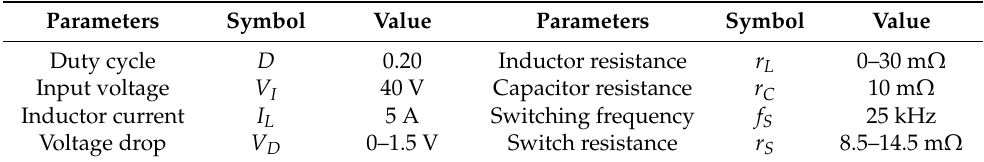
Table 2. Non-ideal components.